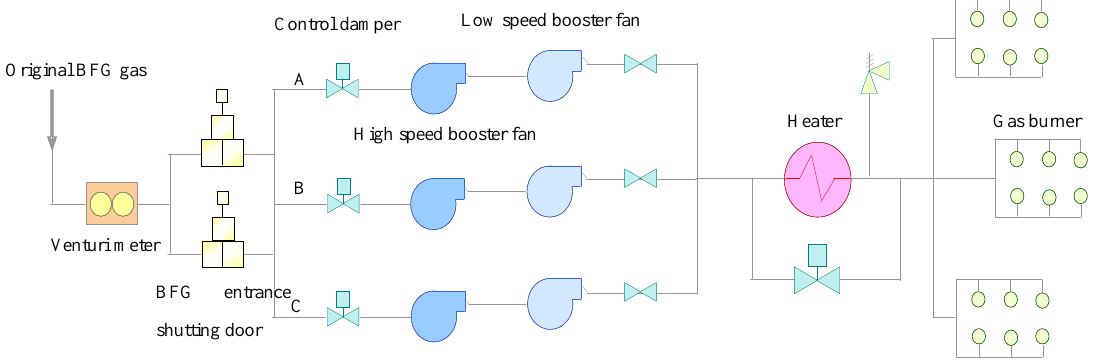
Figure 1. The structure of the BFG booster fans in Unit 4.